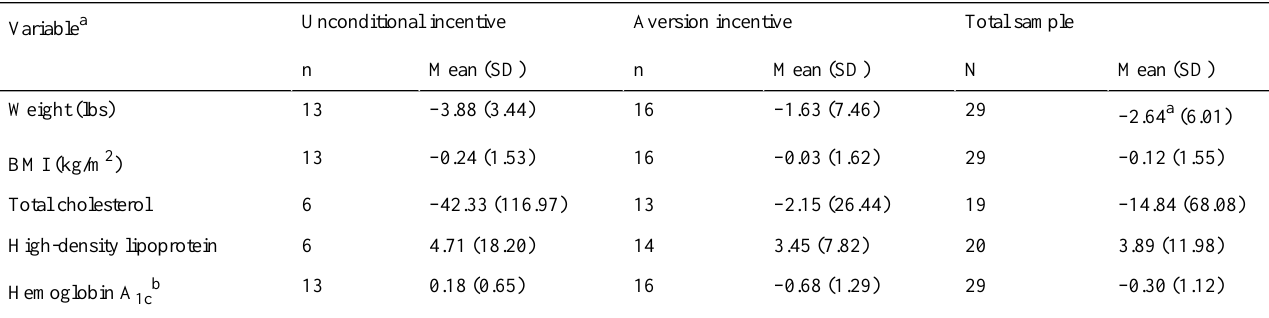
Table 8. Unadjusted changes of the outcome measures from baseline to follow-up by treatment group and for total study